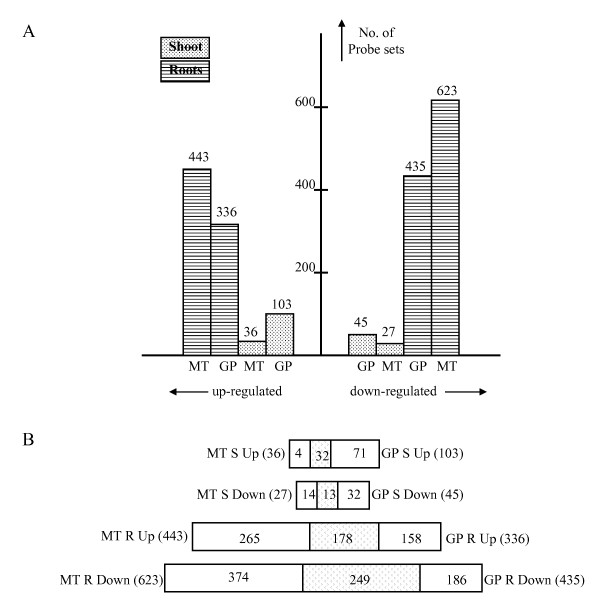
Salinity stress responsive genes in Maythorpe and Golden Promise. A. Number of probe sets up- and down-regulated in root (horizontal lines) and shoot tissue (dots) of the two genotypes. B. Venn diagram stating the overlap between the up- and down-regulated probe sets in Maythorpe (MT) and Golden Promise (GP). The overlap between the two genotypes is shaded with dots. The total number of probe sets responding in each the genotypes is indicated in brackets ().